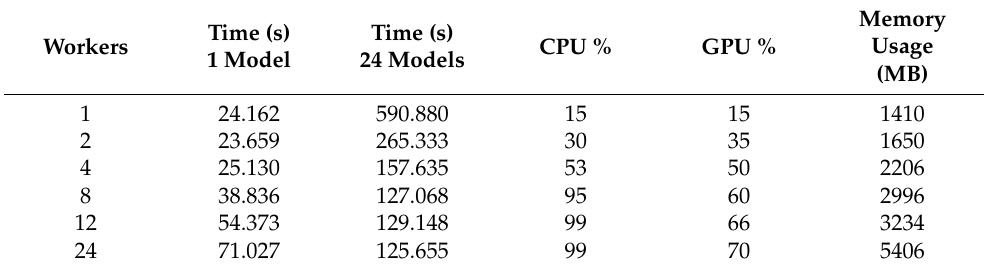
Figure 6. Scheme of data parallel implementation. Table 1. Execution times and performance of the GPU and CPU through the training process of the general